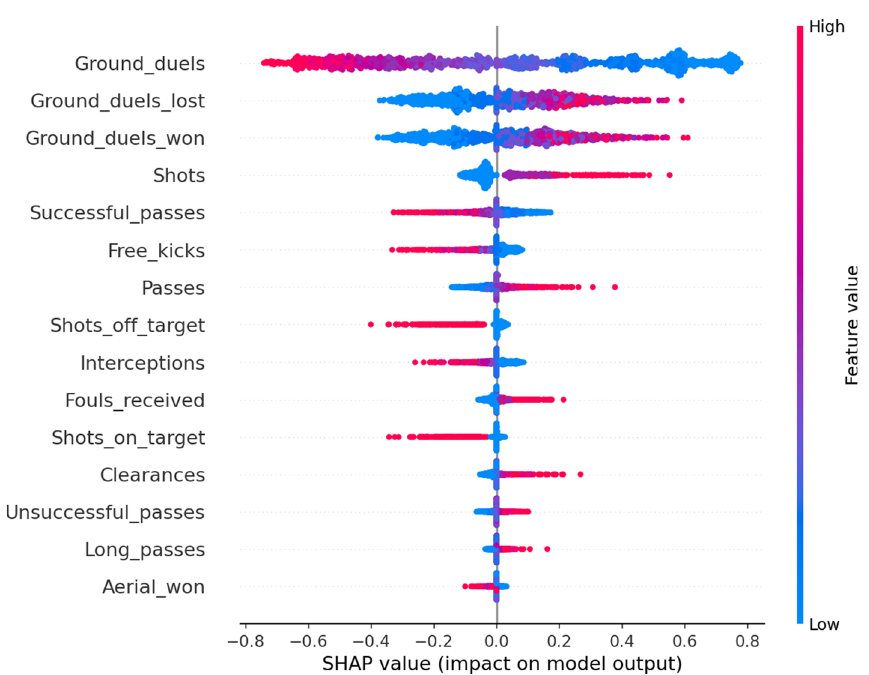
Figure 4. SHAP summary plot with the top 15 features ordered by feature importance. The class reference is defined as Female. A high number of ground duels increases the probability of the model classifying a female player. On the other side, high value of ground duels decreases the likelihood of prediction class Female, which is equivalent to increase the probability of predicting a male